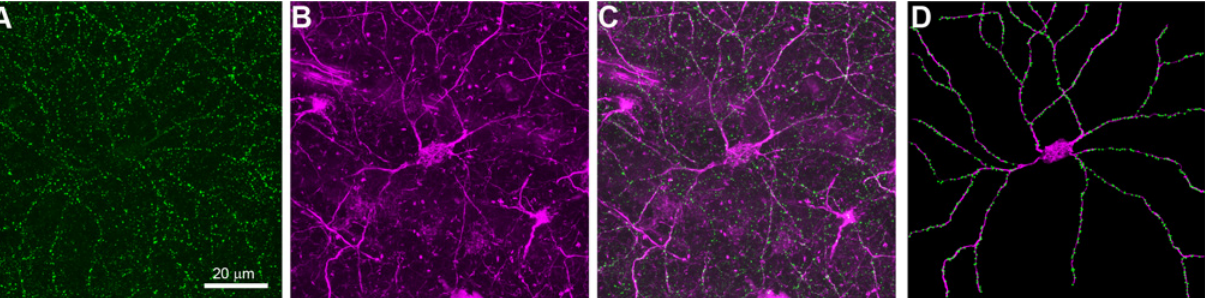
Fig 2. Labeling synaptic input on individual retinal ganglion cells in non-glaucomatous retinas. A, Excitatory synaptic inputs were labeled by AAV2-mediated transfection of ganglion cells with PSD-95-GFP, leading to a punctuate labeling. B, To assign synaptic puncta to individual ganglion cells, the cytoskeleton of large ganglion cells was labeled with an antibody against neurofilament. C, Overlay of A and B. D, Digital representation of the dendritic arbor with assigned synaptic input sites.